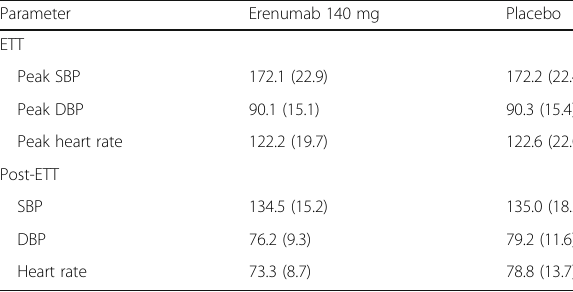
Table 1 (abstract P15). Outcome measures